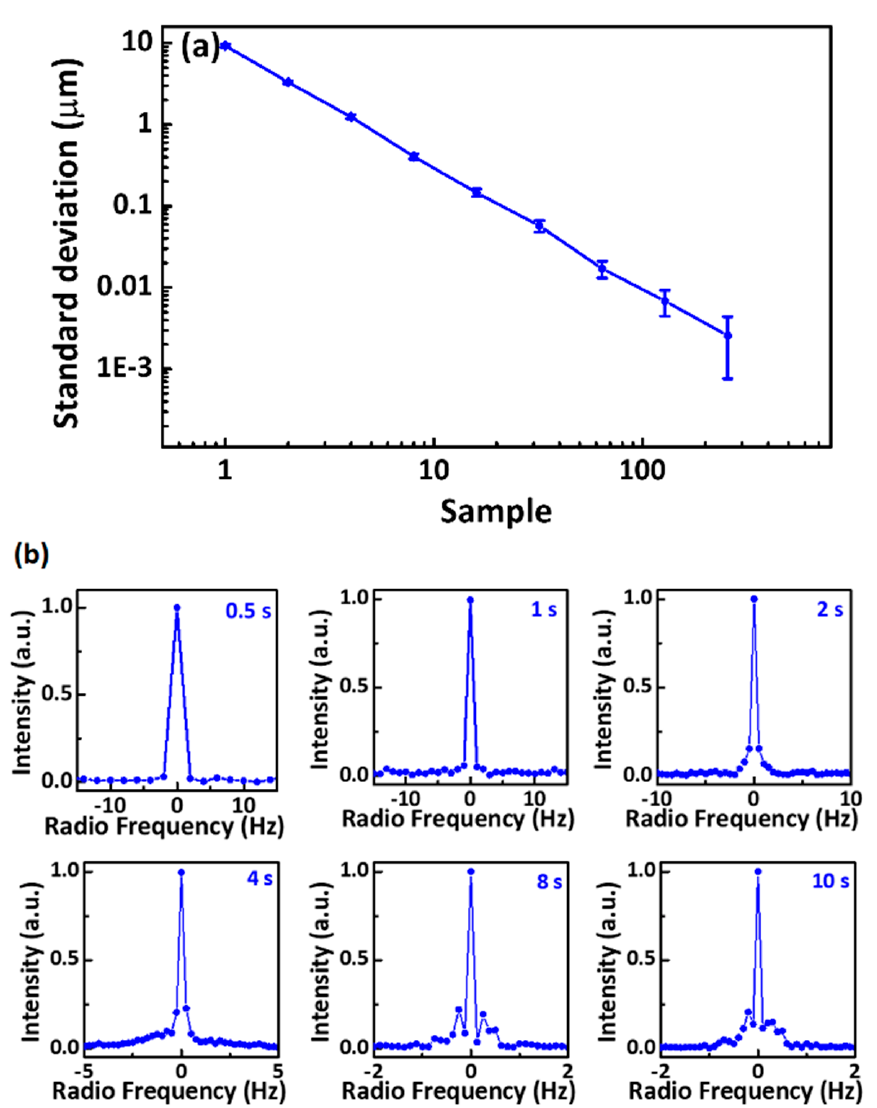
Figure 2. Two interferograms in the time domain. ( a ) Captured reference interferogram (red) and signal interferogram (blue). ( b ) Magnified view of interferograms.